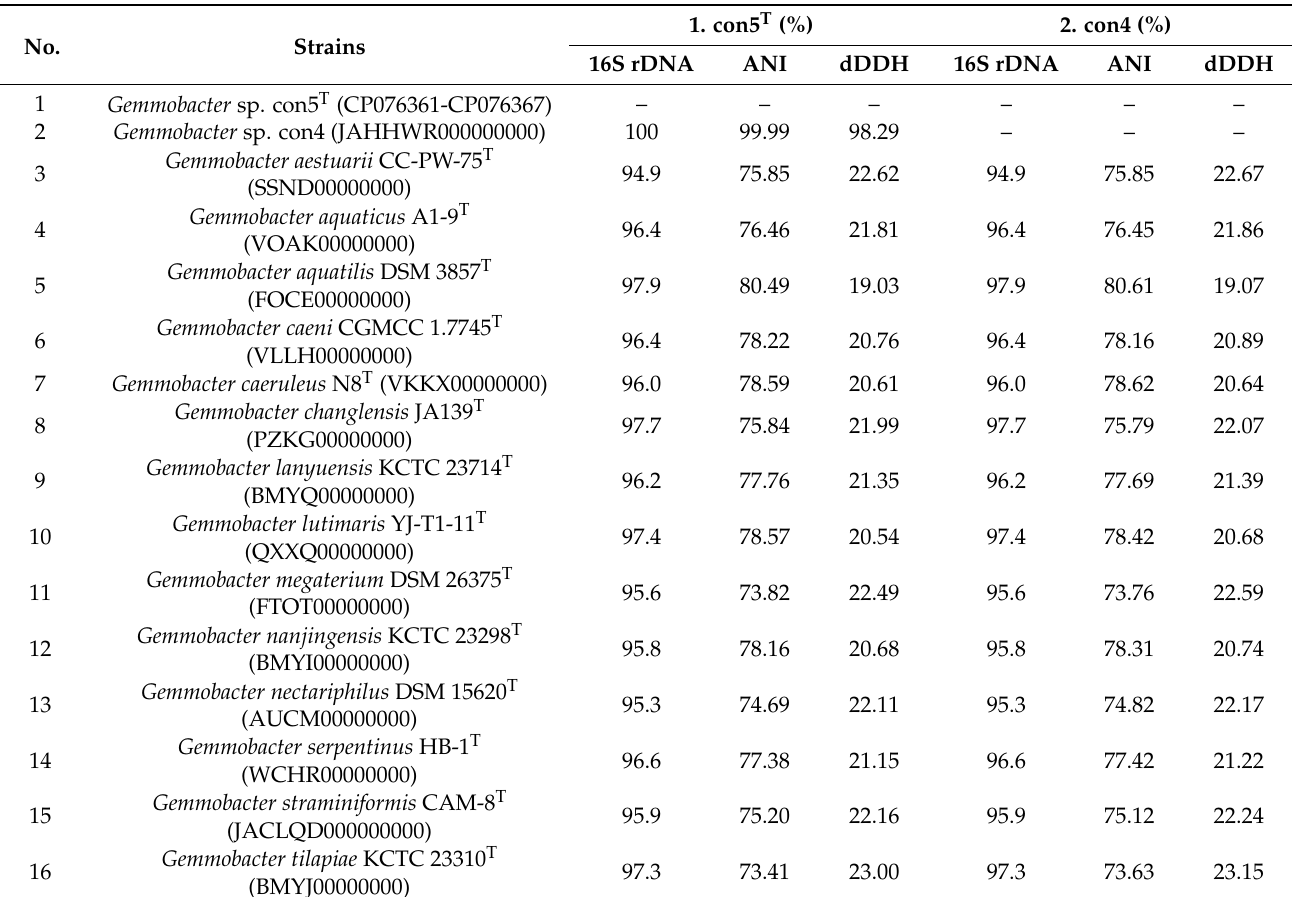
Table 2. General features and relationship of the genomes of strains con5 T and con4 with the closely related species of the genus Gemmobacter